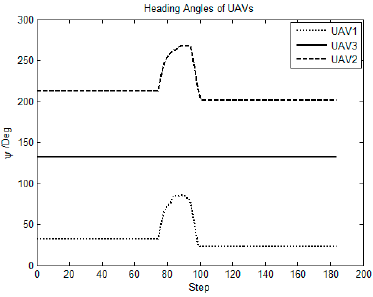
Figure 11. Heading angles of 3 UAVs.